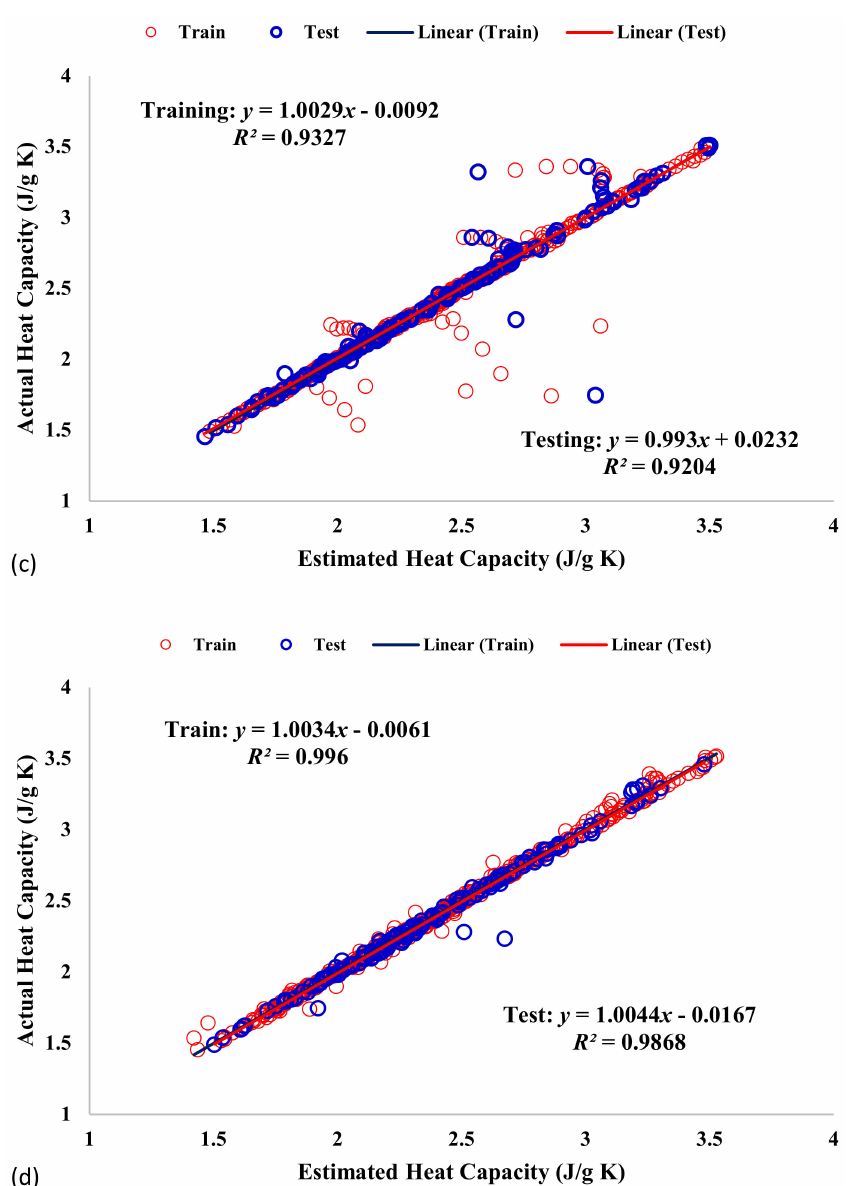
Figure 5. Regression diagram for predict C p using di ff erent models in the training and testing steps: ( a ) ANFIS, ( b ) MLP–ANN, ( c ) RBF–ANN, and ( d )